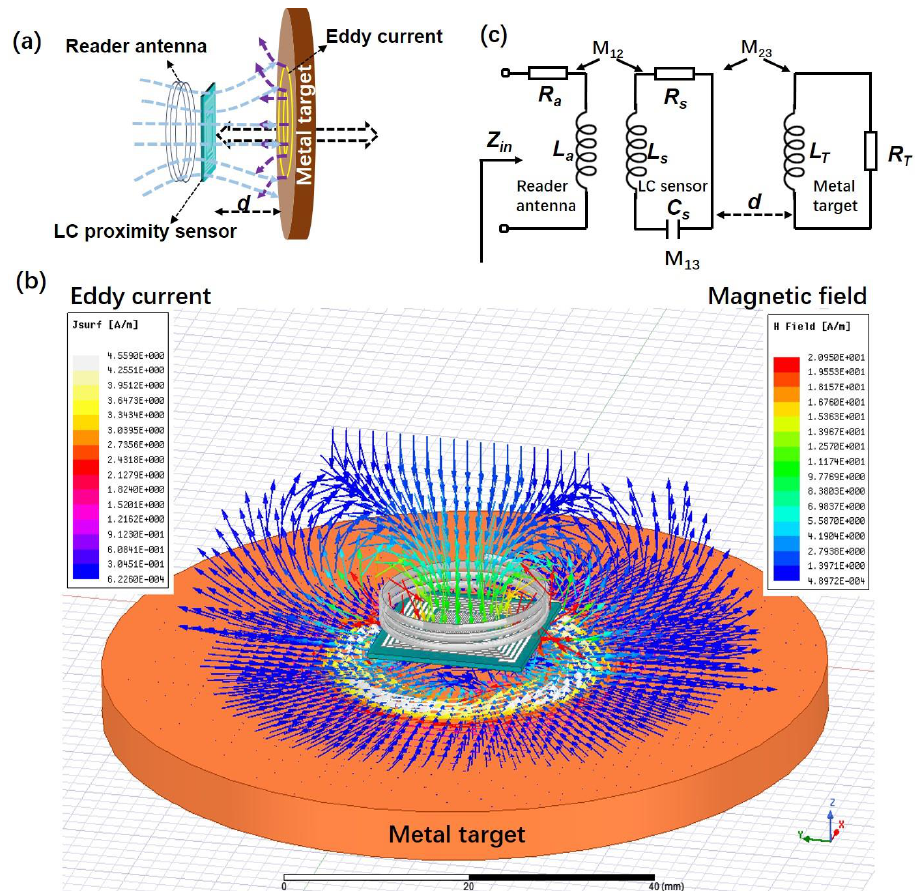
Figure 2. ( a ) Schematic diagram of the LC proximity sensor for metal target. ( b ) Electromagnetic simulation on the distribution of the eddy current and magnetic field. ( c ) Equivalent circuit of the proximity sensing system.